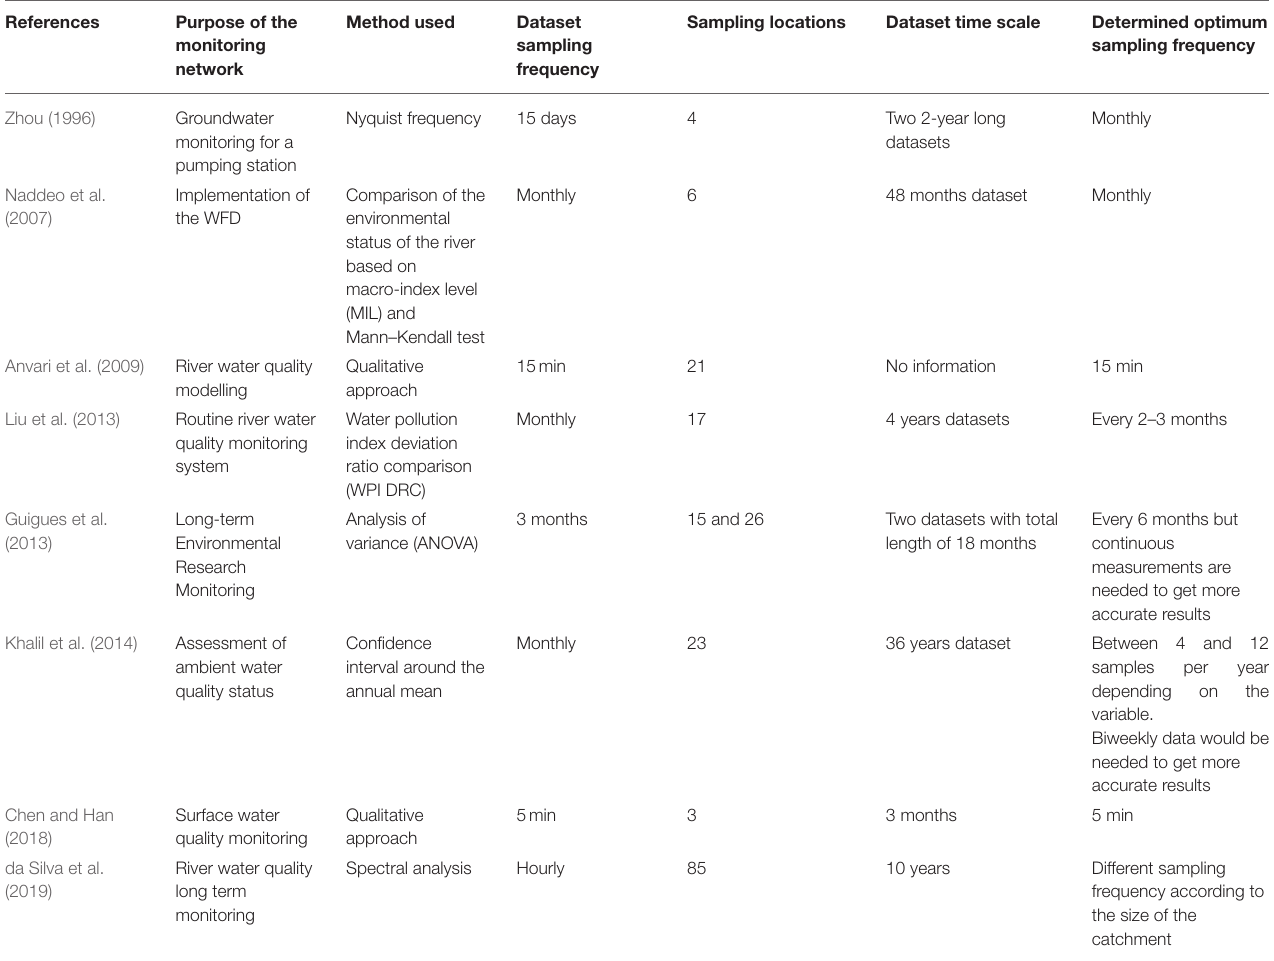
TABLE 2 | Sampling frequency optimisation approaches used in